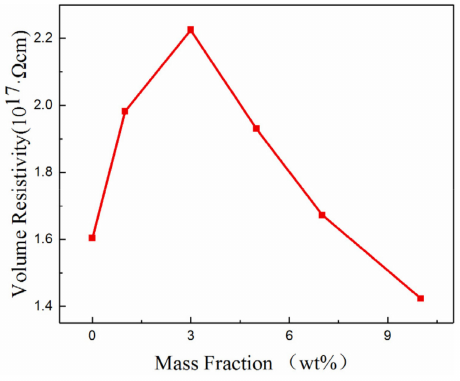
Figure 5. Volume resistivity of Al 2 O 3 -NWs / epoxy resin composites with di ff erent mass